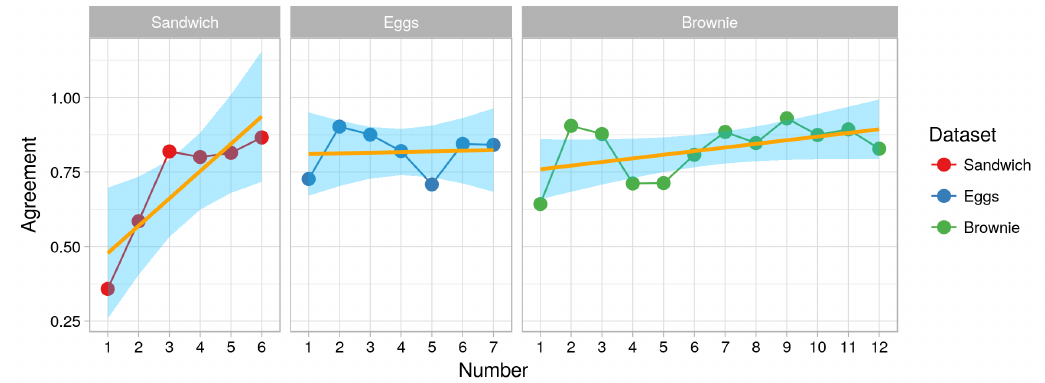
Figure 7. Learning curve for the first n videos. The points illustrate the percentage of interrater agreement for one dataset. The points are connected to increase perceivability. The orange line illustrates the increase of reliability due to